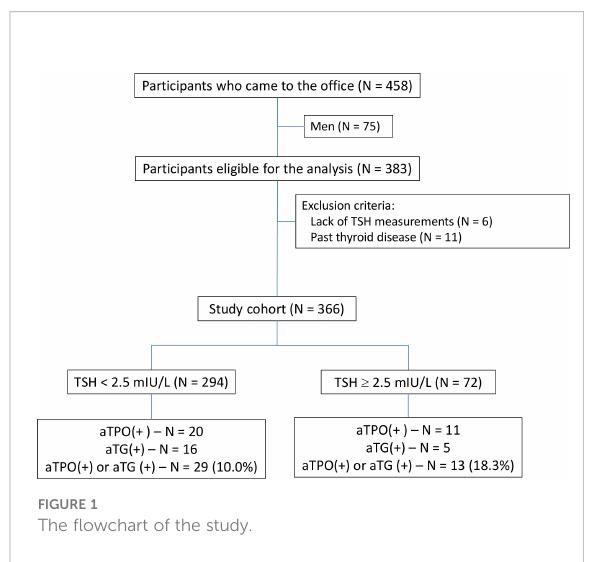
FIGURE 1 The fl owchart of the